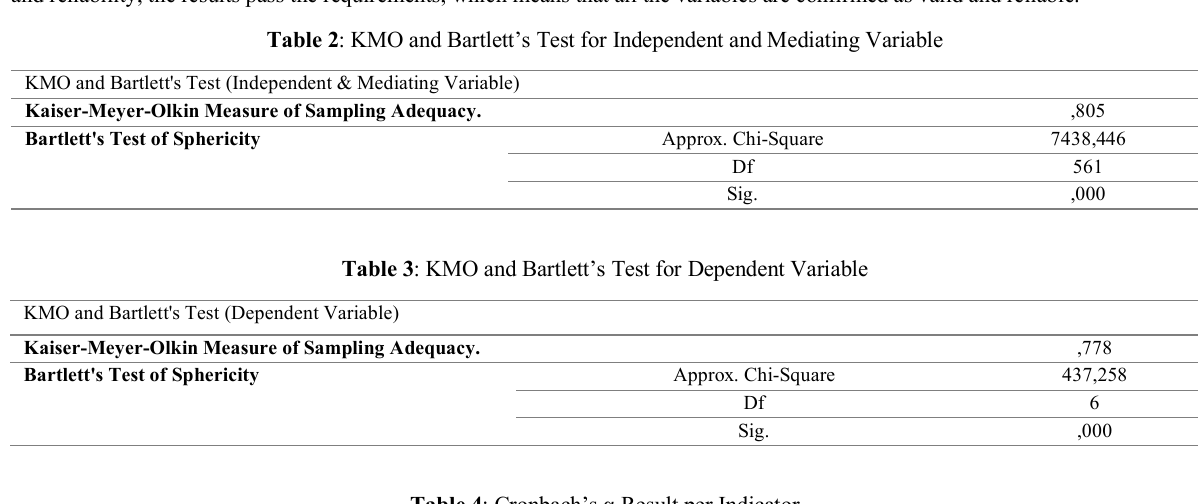
Table 4 : Cronbach’s α Result per